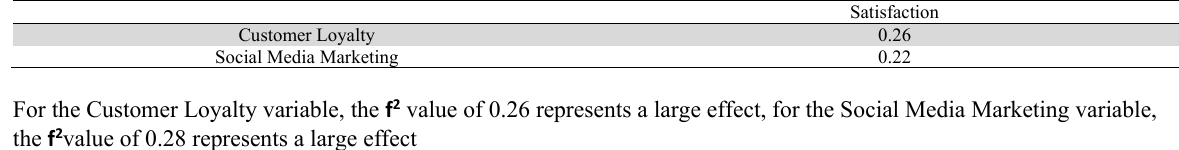
f 2 Effect Sizes